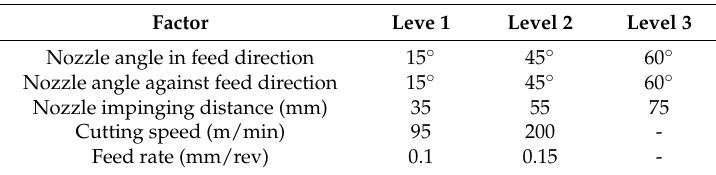
Table 2. Process variables and corresponding levels.